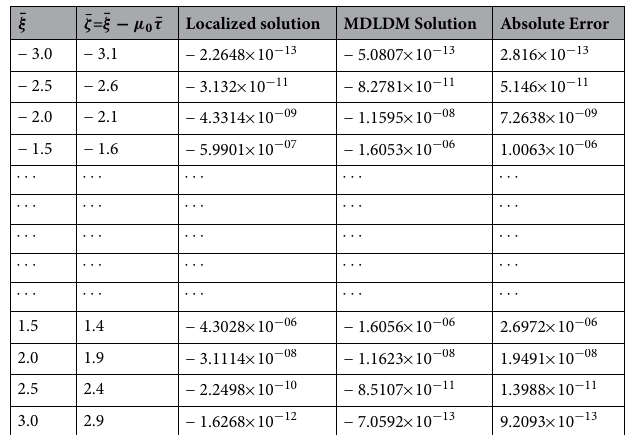
Table 1. Comparison of localized solution with approximate solution for µ 0 = 1 ,and ¯ τ( = τω 0 ) = 0.1 .